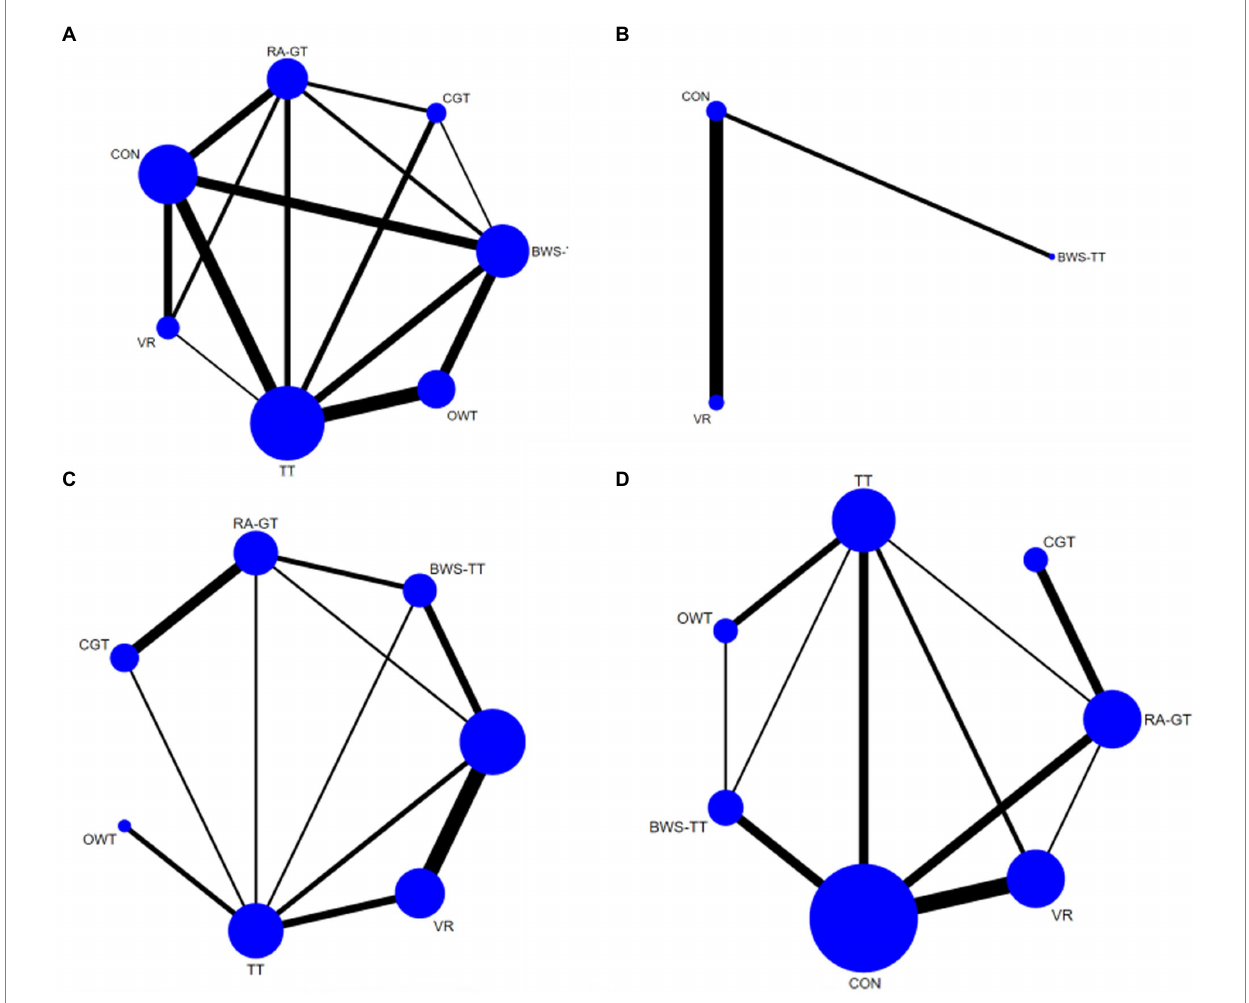
FIGURE 3 Network plots of the outcomes of the comparisons between gait training and controls in the NMA. (A) Dynamic steady-state balance; (B) Static steady- state balance; (C) Proactive balance; (D) Balance test batteries. TT, treadmill; BWS-TT, body-weight-supported treadmill training; RA-GT, robot-assisted gait training; VR, virtual-reality gait training; CGT, conventional gait training; OWT, overground walking training. Treatments with direct comparisons are linked with a line; the thickness of connecting lines corresponds to the number of trials evaluating the comparison; the size of the circle is proportional to the sample